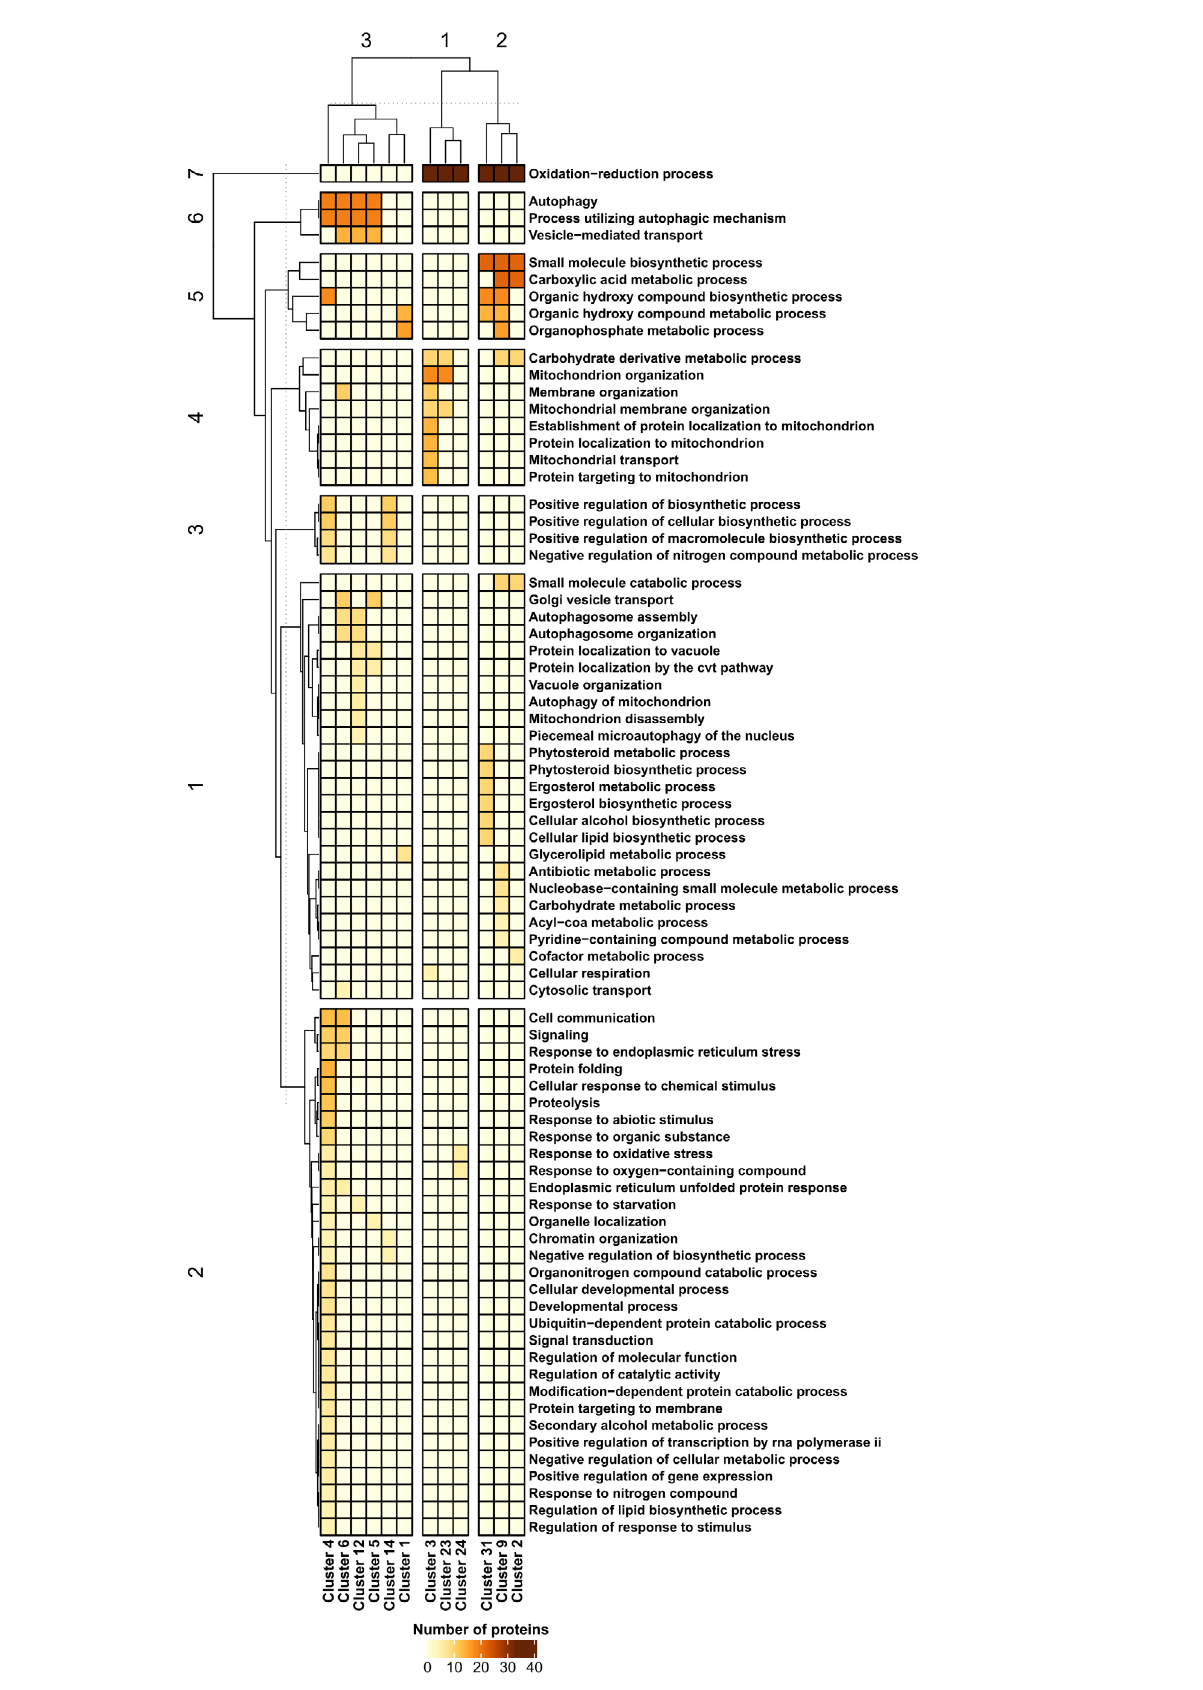
Figure 3 - Heatmap showing the clustered biological processes based on the gene ontology (GO) analysis of autophagy, lipid metabolism, and proteostasis (ALP) network-associated communities/clusters. Heatmap rows and columns were grouped using the k-means distance-based method. Horizontal and vertical dotted lines indicate the cut-off point used to define the numbered rows and column